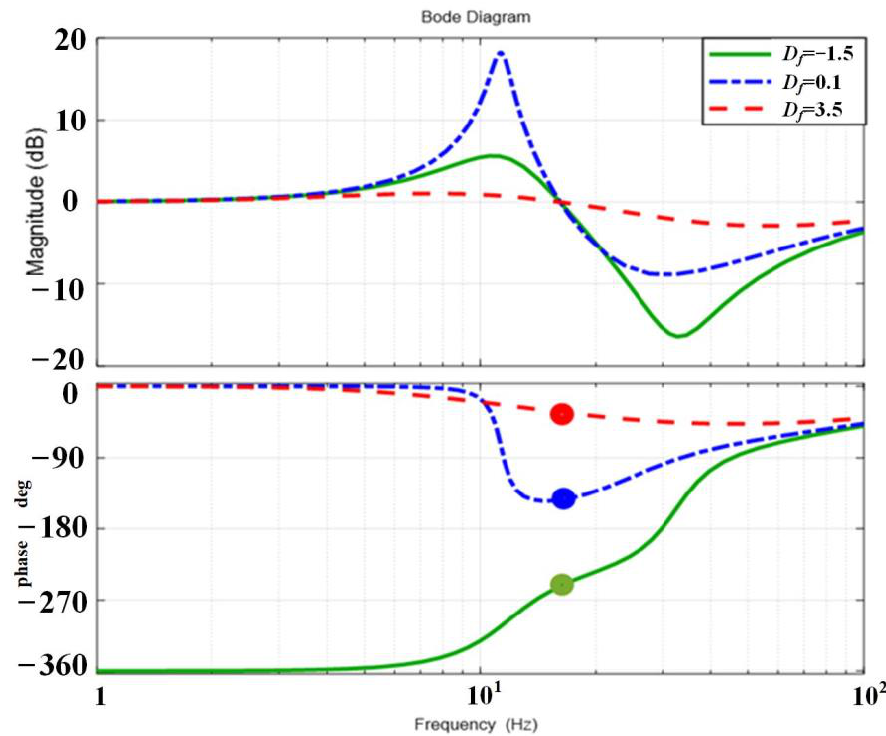
Figure 13. Bode diagram of G 2 ( s ) for different values of D f .